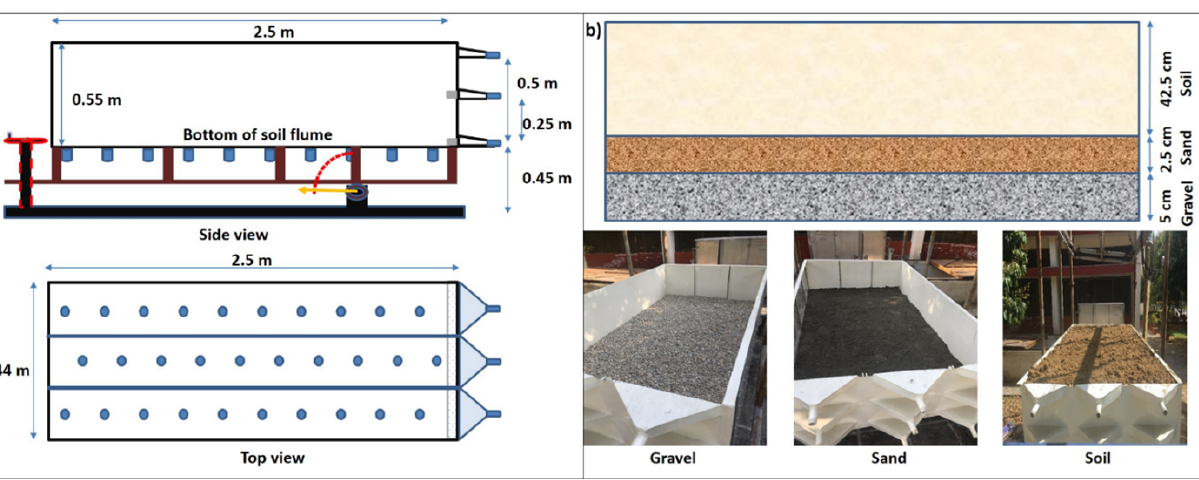
Figure 2. (a) Design of soil flume (not in scale) and (b) filling materials used in soil